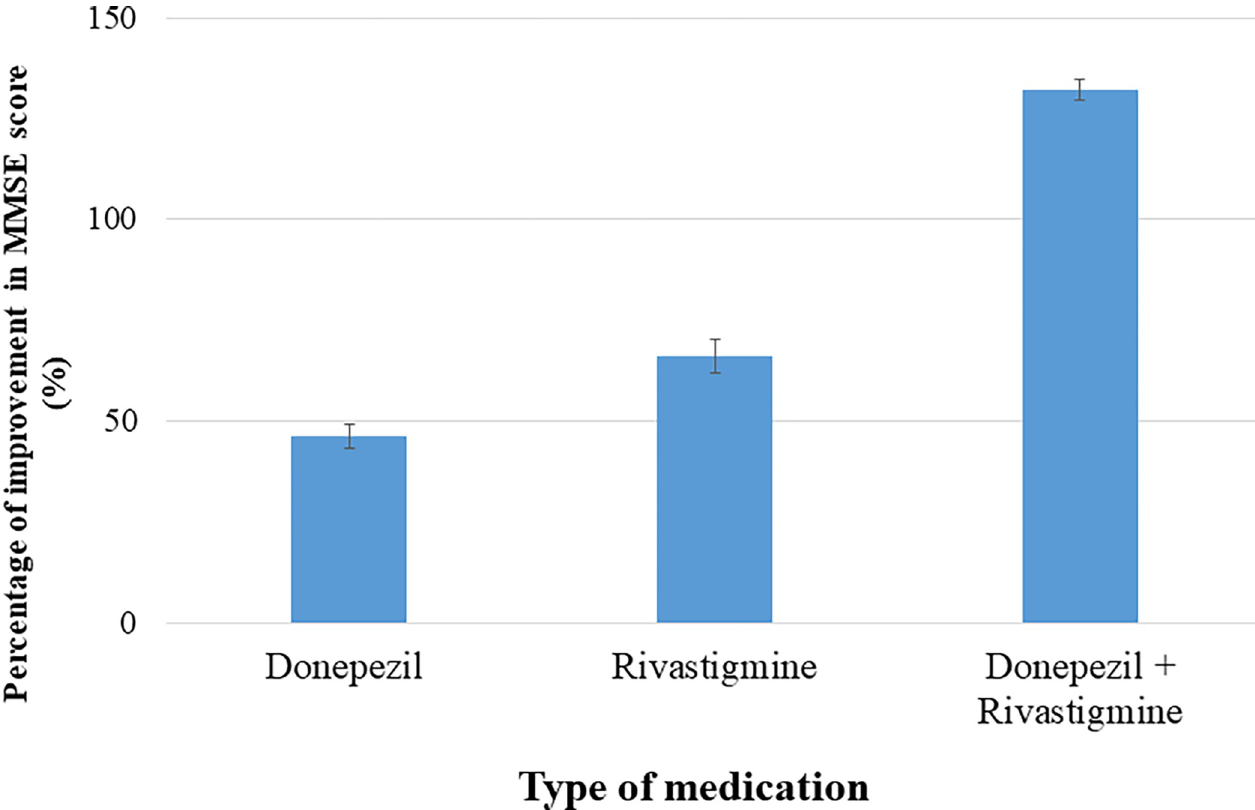
Fig 5. Percentage of improvement in MMSE score with each medication. The best improvement in MMSE score was seen when using a combined therapy with donepezil and rivastigmine in contrast with a single medication.